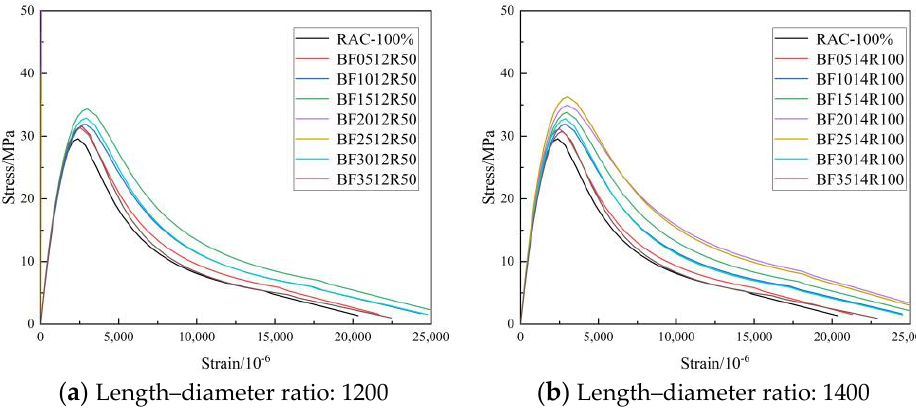
Figure 14. Complete stress – strain curve of BFRAC-100% under uniaxial compression.